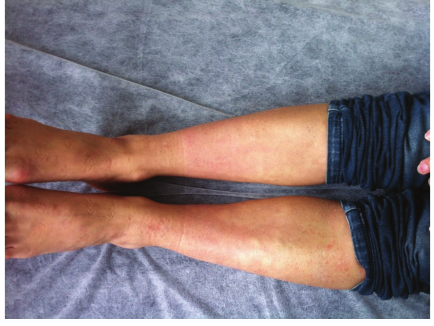
Figure 8: Target lesions on her arm.